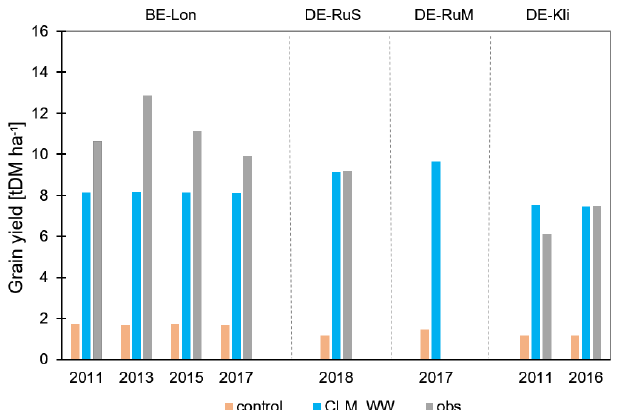
Figure 4. Annual grain yield (tDMha − 1 ) simulated with the con- trol run (orange) and the extended winter wheat model with crop- specific parameterization (blue), compared to recorded harvest yields (grey) for all simulated winter wheat years (indicated on the x axis) at the sites BE-Lon, DE-RuS, DE-RuM, and